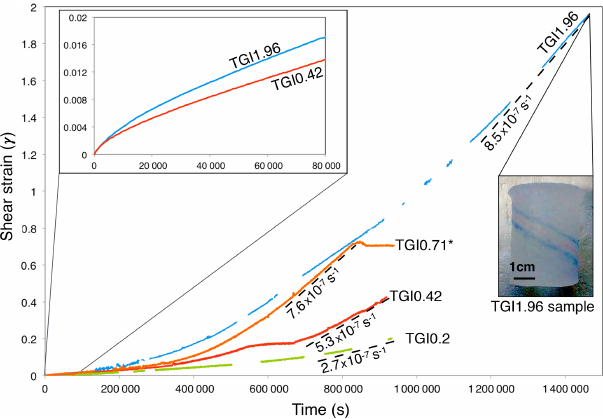
Figure 1. Creep curves for TGI0.2, TGI0.42, TGI0.71 and TGI1.96 experiments with the tangent to end of curve as black dashed lines, and corresponding final strain rate ˙ ε f . The blank parts of some of the curves correspond to a loss of signal between the acquisition setup and the sensor located in the cold room. In the top left frame is a zoom on the primary creep regime ( < 10h) for better readability. The photograph in the bottom right shows the TGI1.96 sample after unloading, with the inclined ink color stripes, initially straight, used as strain